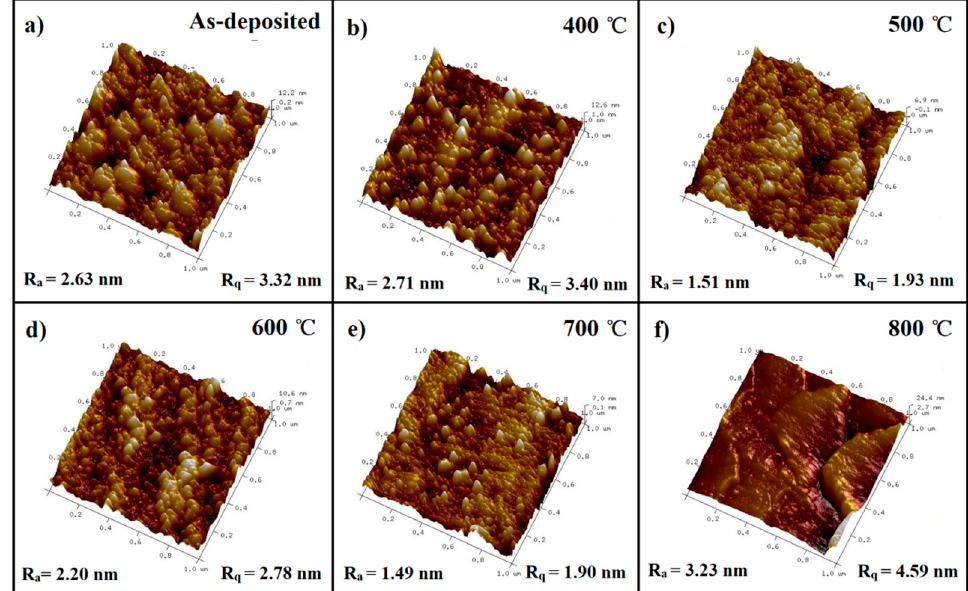
Figure 4. AFM images and surface roughness data (R a - Arithmetic Mean Roughness, R q - Root-Mean-Square Roughness) of as-deposited and annealed TiC thin films with a thickness of 610 nm.